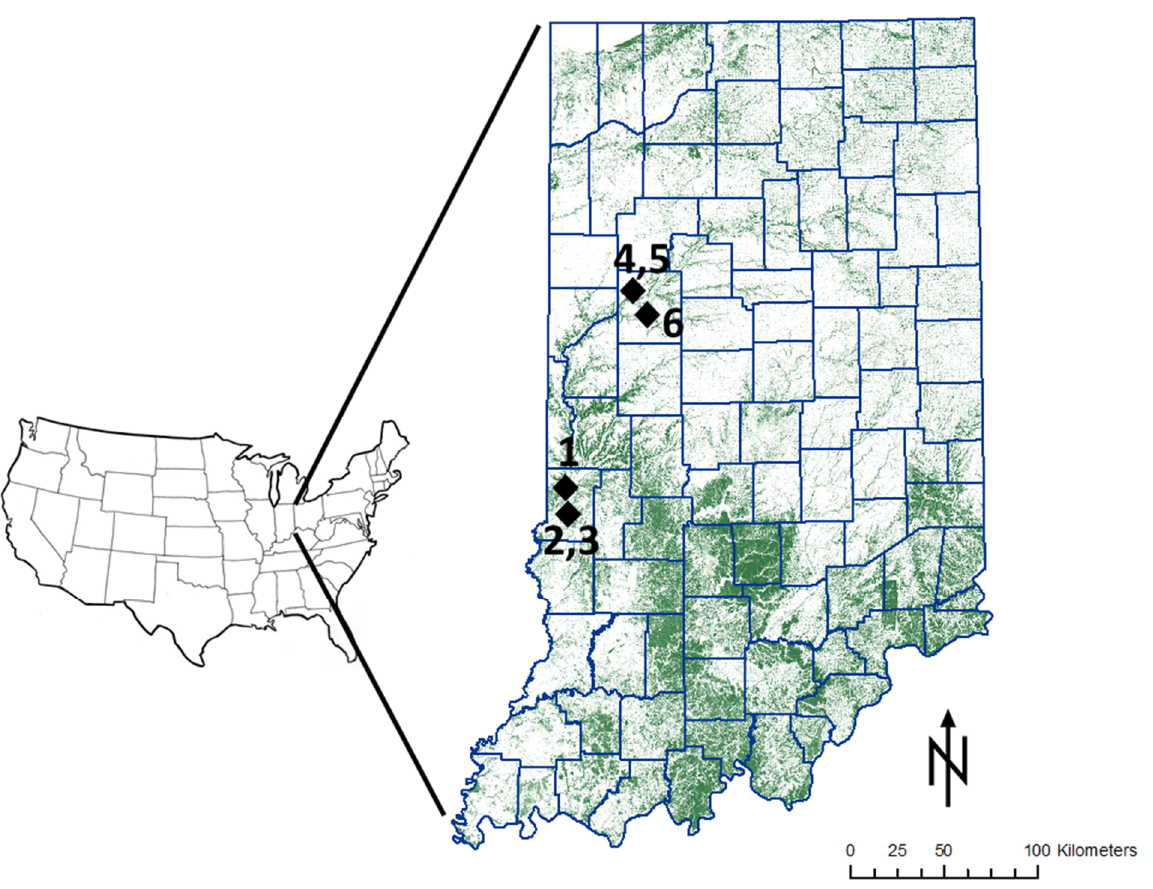
Figure 1. Location of study sites within Indiana, USA. 1 = Hawthorn Park, 2 = Fowler Park, 3 = Rifle Range, 4 = FNR Farm, 5 = Ross Biological Reserve, 6 = Pursell Woodlot. Study sites represented by a single symbol were too close together to separate at a state-wide